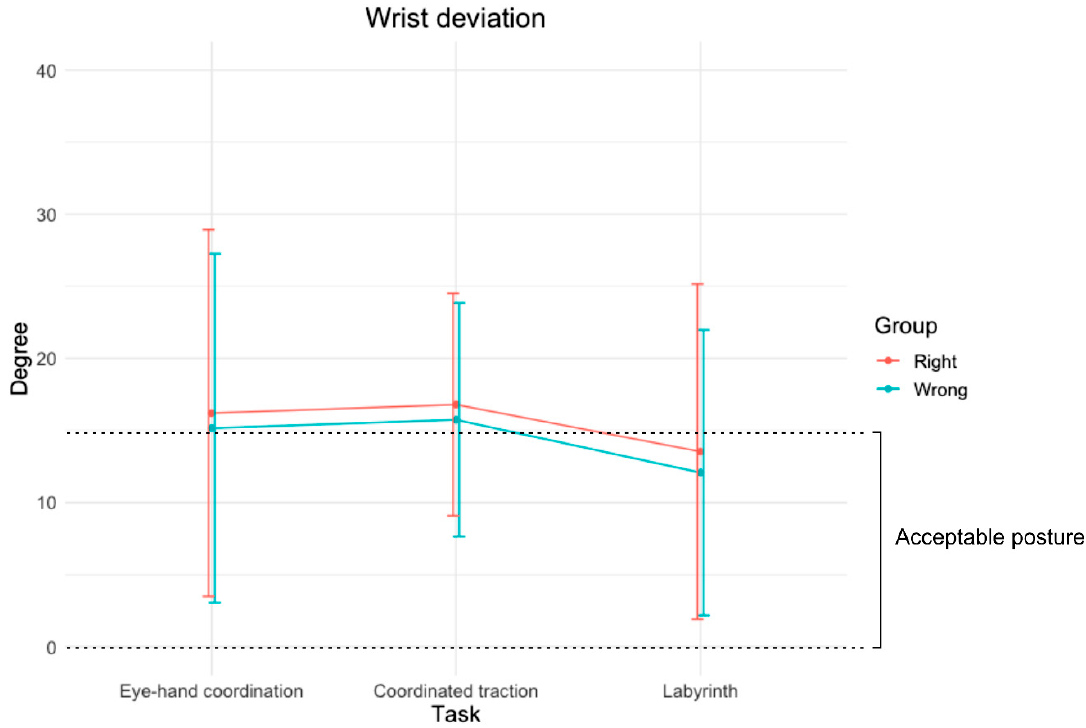
Figure 7. Radio-ulnar deviation of the surgeons’ wrist during the laparoscopic tasks using the right and wrong size of instrument handle. The graph indicates the acceptable posture of the wrist according to RULA method.